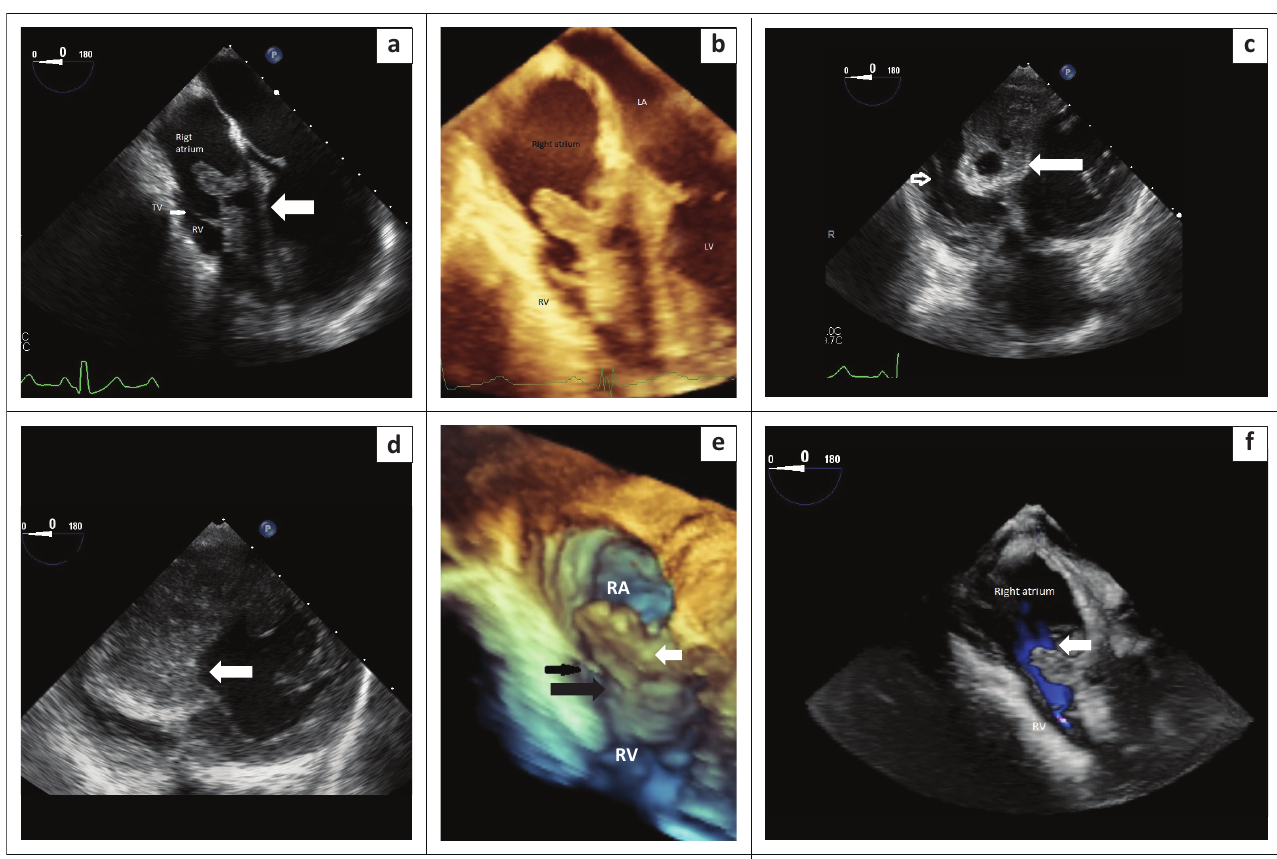
LV, left ventricle; LA, left atrium; TV, tricuspid valve; RV, right ventricle; RA, right atrium. FIGURE 2: (a) Two- and three-dimensional transoesophageal echocardiography view of the heart at the mid-oesophageal level showing infiltration of the entire interventricular septum (open white arrow) by the hydatid cyst and reduction of the right ventricle to a slit-like cavity. (b) The hydatid cyst protrudes into the right atrium without causing tricuspid valve dysfunction. (c and d) Two-dimensional transoesophageal echocardiography trans-gastric view showing infiltration of the interventricular septum by the hydatid cyst (solid white arrow) and its relation to the tricuspid valve (open arrow, c). Deep trans-gastric view depicting septal hypertrophy due to hydatid disease (white arrow) mimicking asymmetrical septal hypertrophic cardiomyopathy (d). (e and f) Three-dimensional echocardiographic reconstruction of the right atrium (RA) and right ventricle (RV) showing the anterior location of the hydatid cyst protruding into the right atrium (white arrow) relative to the tricuspid valve (black arrow) at the base of the heart (e), and unobstructed blood flow through the tricuspid valve (white arrow)